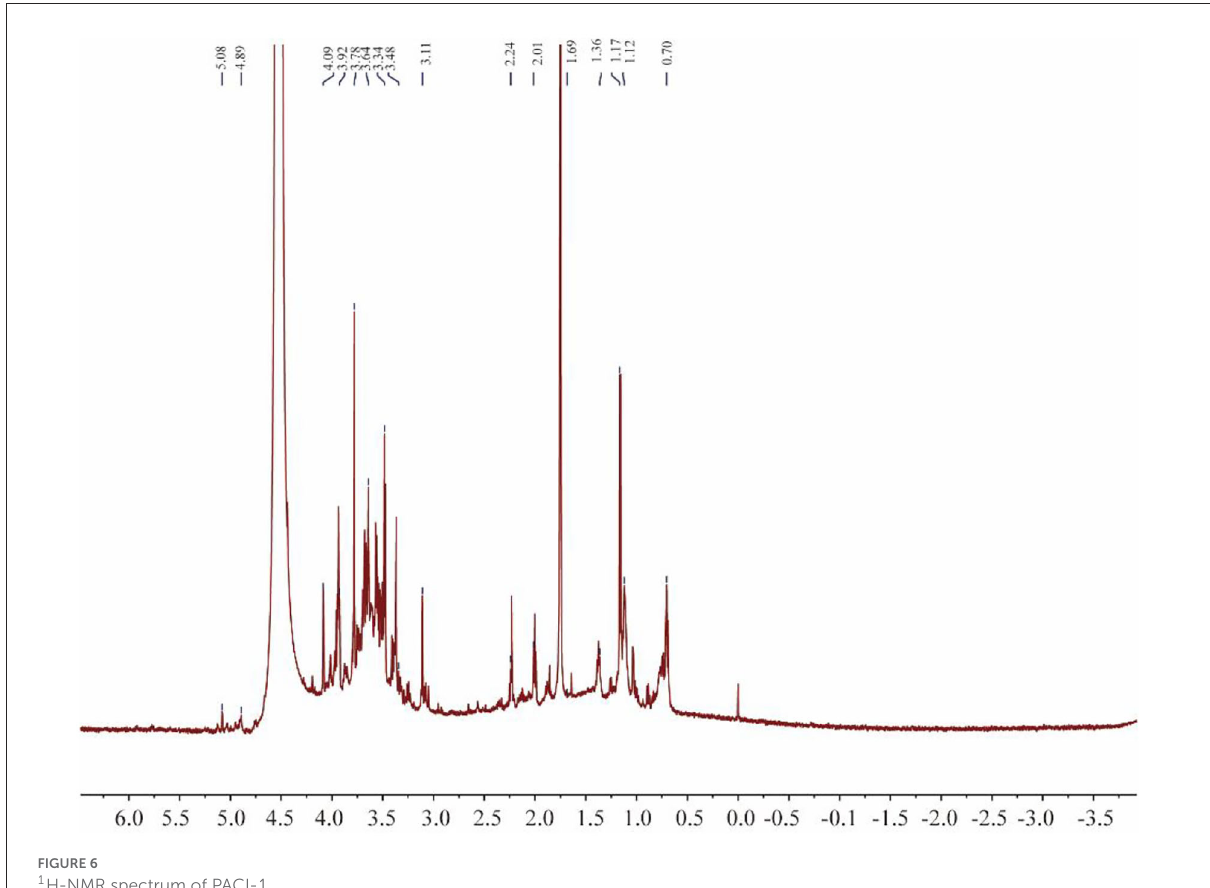
FIGURE6 1 H-NMR spectrum of